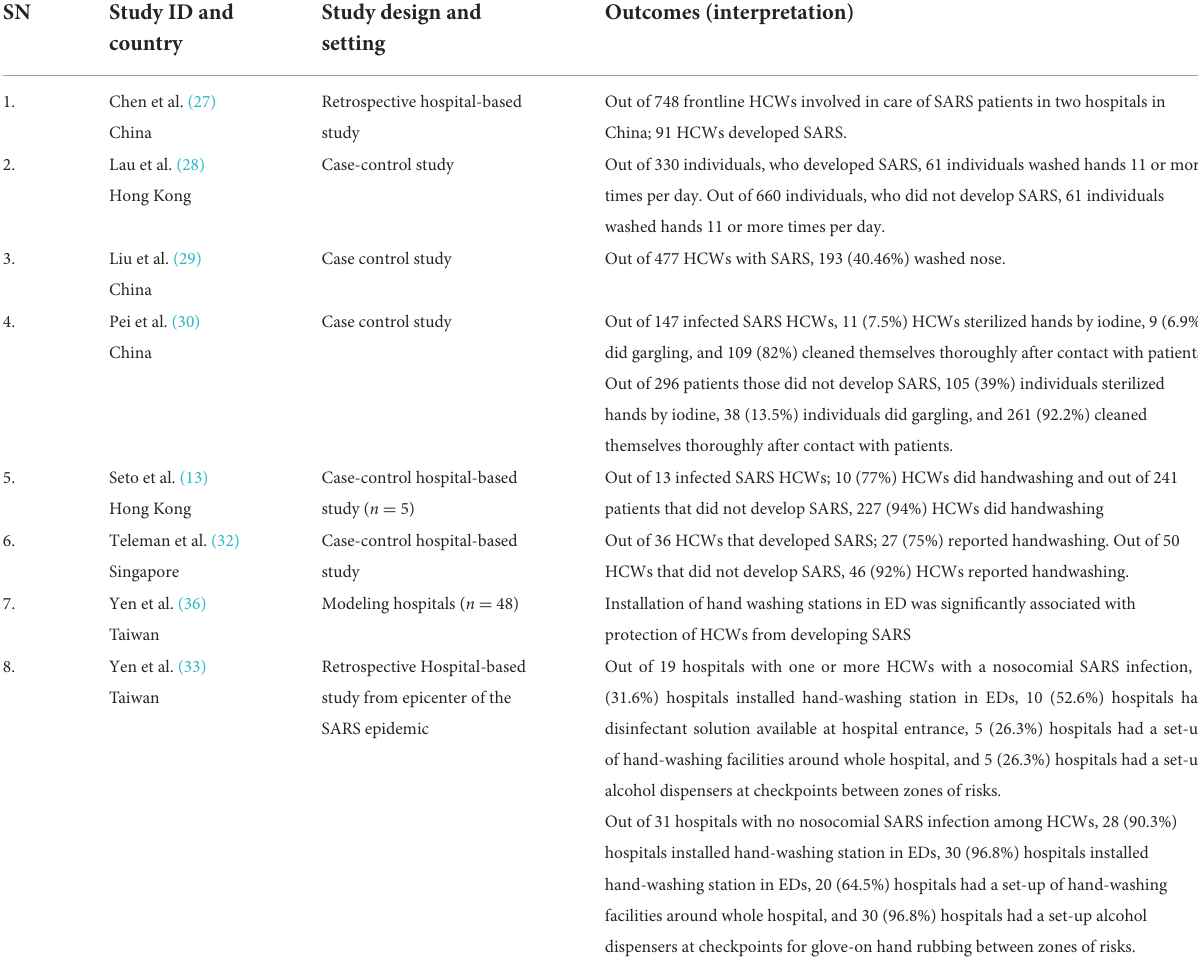
TABLE 4 Results of included studies table (Indirect evidences on COVID-19 from SARS cases for primary outcome of Incident cases). SN